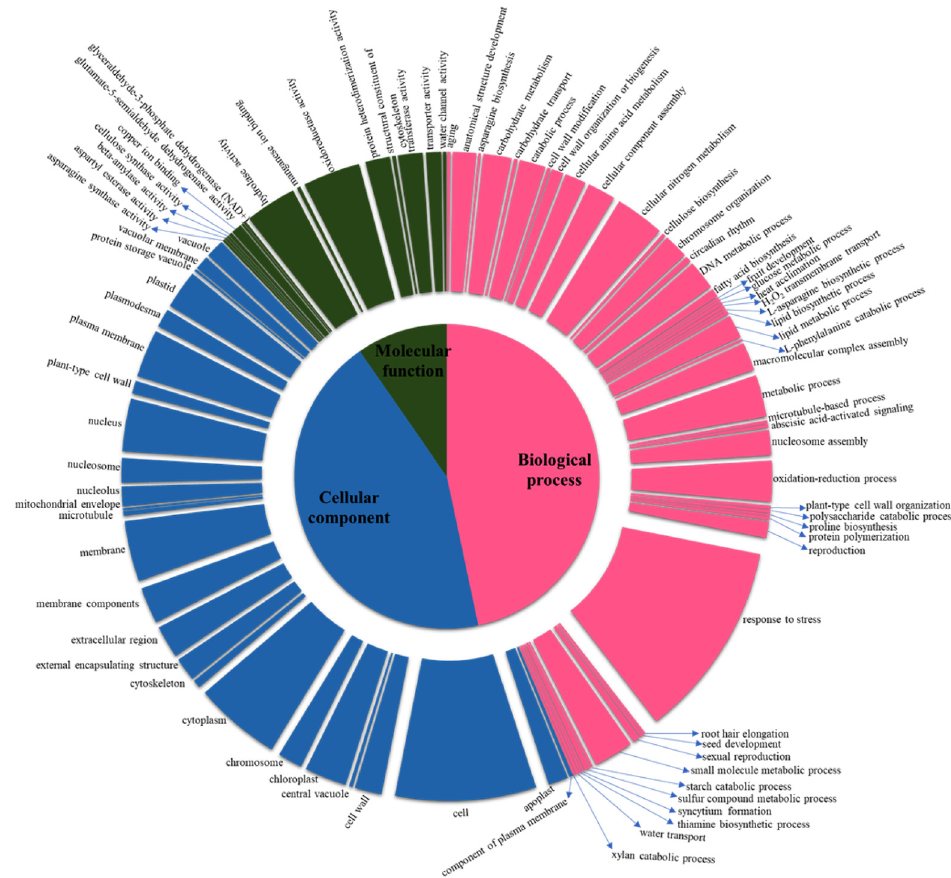
Figure 10. Gene ontology analysis of drought responsive DEGs in maize, threefold change expres- sion.